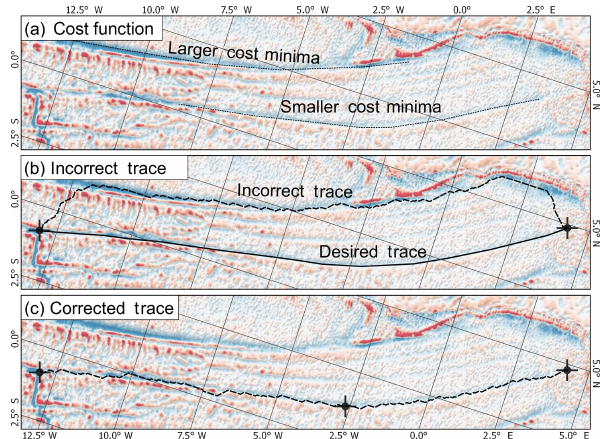
Figure 6. Example of larger cost minima (a) causing the incorrect reconstruction (b) of an oceanic fracture zone. In this case the trace can be corrected by adding a single additional control point midway along the fracture zone (c)